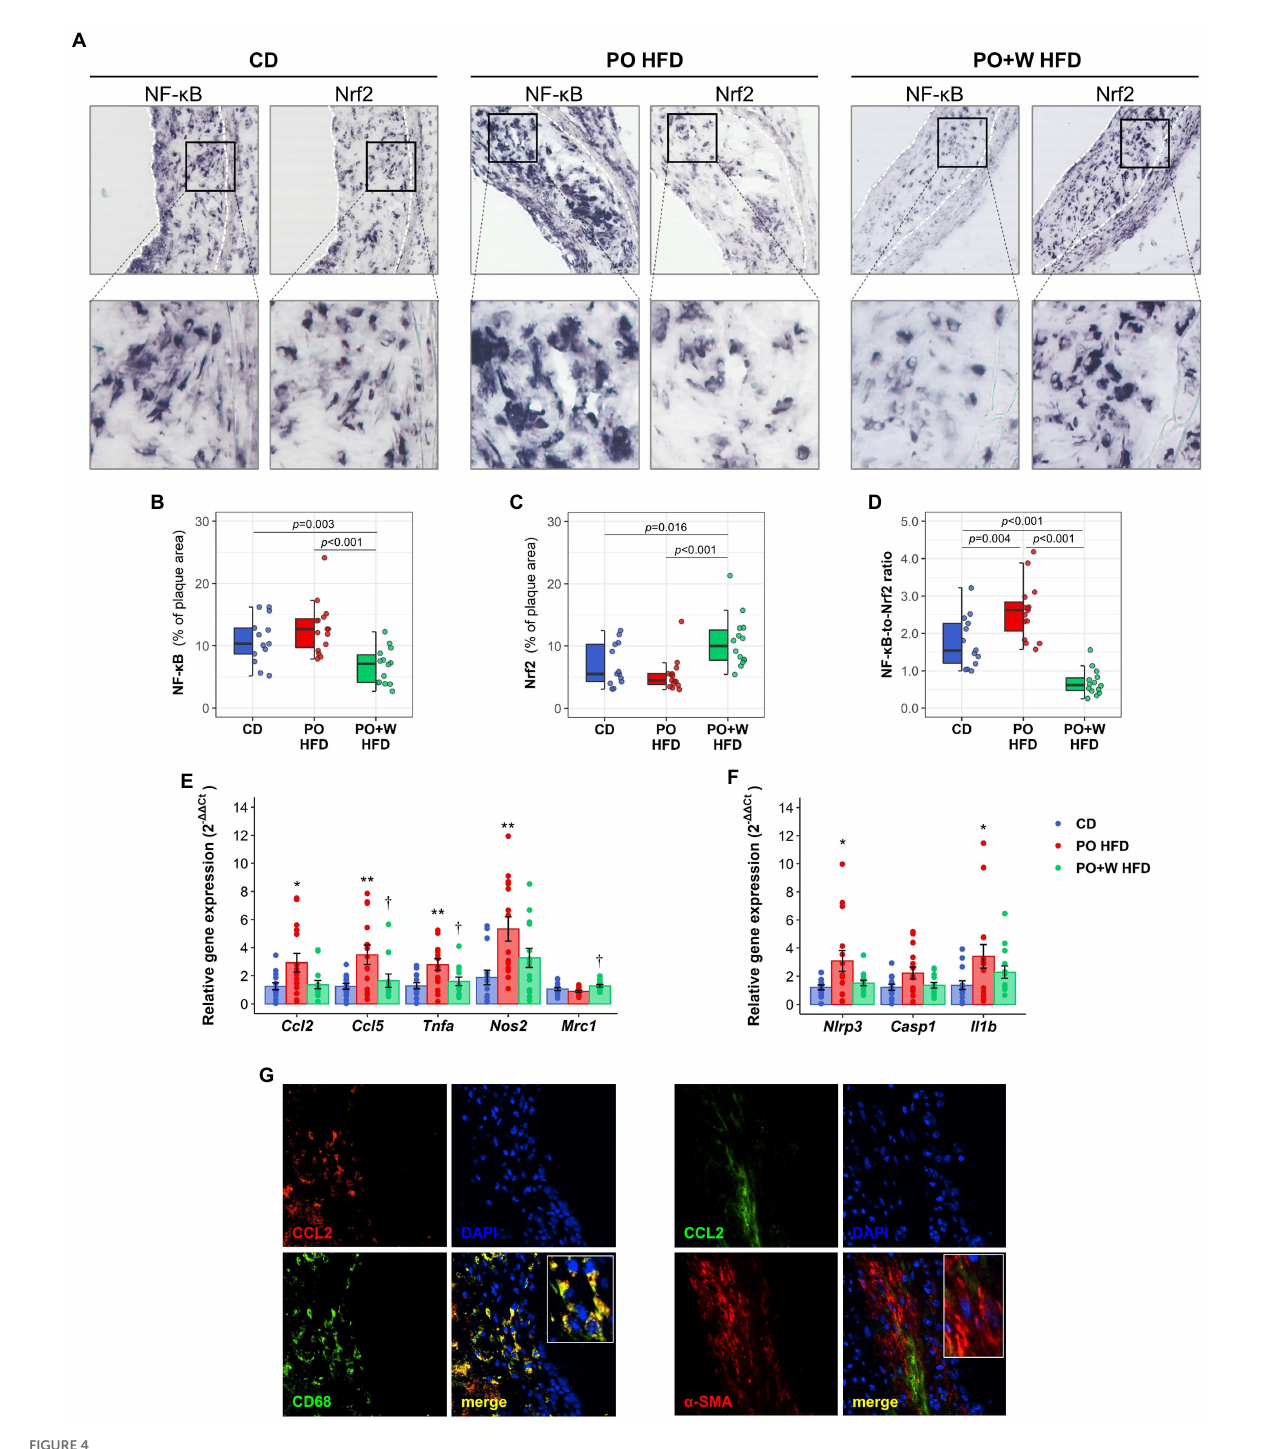
FIGURE 4 Inclusion of walnuts attenuates inflammation in atherosclerotic lesions. (A) Representative images and high-magnification fields of in situ detection of activated NF- κ B and Nrf2 by Southwestern histochemistry in aortic sections. Dashed white lines delimit atherosclerotic lesion areas. Quantitative analysis of percentage of NF- κ B (B) and Nrf2 (C) lesional activation, and individual NF- κ B-to-Nrf2 ratio (D) . Quantitative real-time PCR analysis of chemokines, cytokines, M1 and M2 markers (E) and inflammasome components (F) in mouse aorta. Data normalized by 18S rRNA are expressed as relative gene expression (using 2 – ΔΔ Ct method). Dot and box plots show individual values and depict the median (horizontal bar), interquartile range (IQR, hinges), and 1.5 × IQR (whiskers). Results in bar plots are presented as individual data points and mean ± SEM of the intervention groups. (G) Representative images and high-magnification fields (rectangular areas) in atherosclerotic lesion sections showing immunodetection of CD68+ macrophages (left panel) and α -SMA+ VSMC (right panel), and colocalization with CCL2. CD, control diet ( n = 14); PO HFD, palm oil-based high-fat diet ( n = 15); PO + W HFD, palm oil + walnuts high-fat diet (isocaloric inclusion of 3% of walnuts at expense of palm oil, n = 14). L, lumen. p values obtained by one-way ANOVA (after log-transformation) with Bonferroni post hoc correction. * p < 0.05, and ** p < 0.01 vs. CD, † p < 0.05 vs. PO